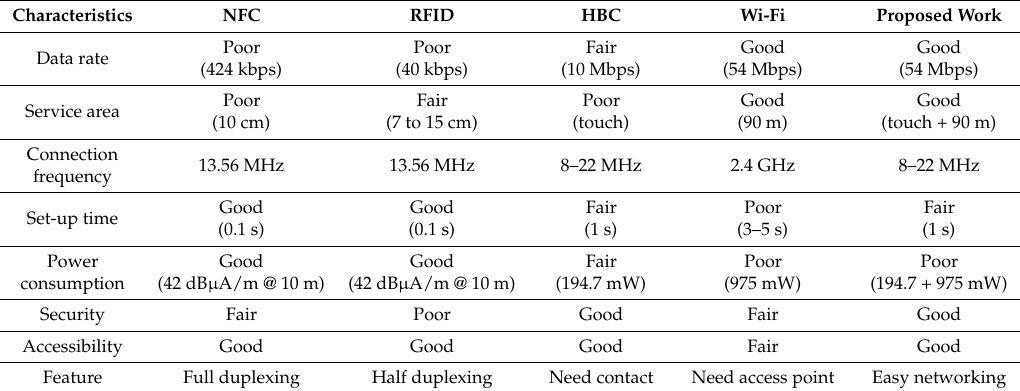
Table 3. Comparison of touch-based dual-band (TBDB) Service with various Communication Services